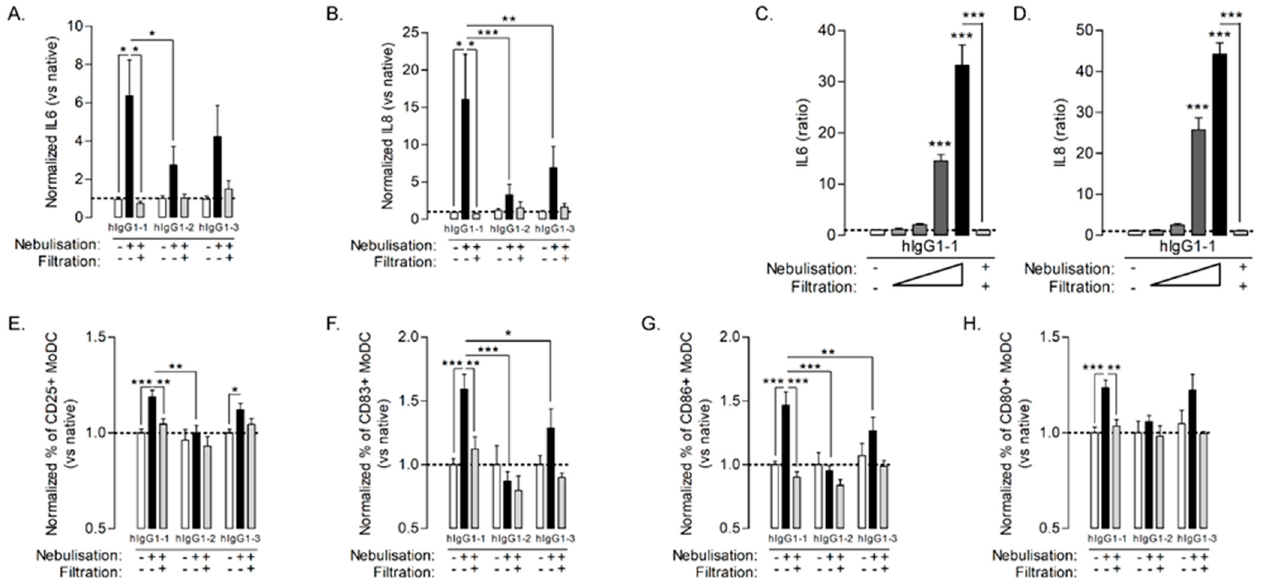
Figure 2. MoDC were stimulated using equal final concentration of Ab at 100 µ g/mL, either native (white bars), nebulized (black bars) or nebulized and 0.45 µ m-filtered (gray bars) for 18 h. IL6 ( A ) and IL8 ( B ) were quantified in cell-free supernatant. MoDC were stimulated with 1, 10, 100 or 200 µ g/mL (gray to black bars) of nebulized hIgG1 or 100 µ g/mL of nebulized and 0.45 µ m-filtered hIgG1 (last bar) or left untreated (white bars) for 18 h. IL6 ( C ) and IL8 ( D ) were quantified in cell-free supernatant. MoDC were stimulated using equal final concentration of Ab at 100 µ g/mL either native (white bars), nebulized (black bars) or nebulized and 0.45 µ m-filtered (gray bars) for 18 h. CD25 ( E ), CD83 ( F ), CD86 ( G ) and CD80 ( H ) expression were measured using flow cytometry. The data are quoted as the mean ± SEM. *, **, ***: p < 0.05, p < 0.01 and p < 0.001, respectively, in a one-way ANOVA with Newman–Keuls correction for multiple comparisons. The results are representative of six independent experiments ( n = 6–9 technical replicates/experiment).